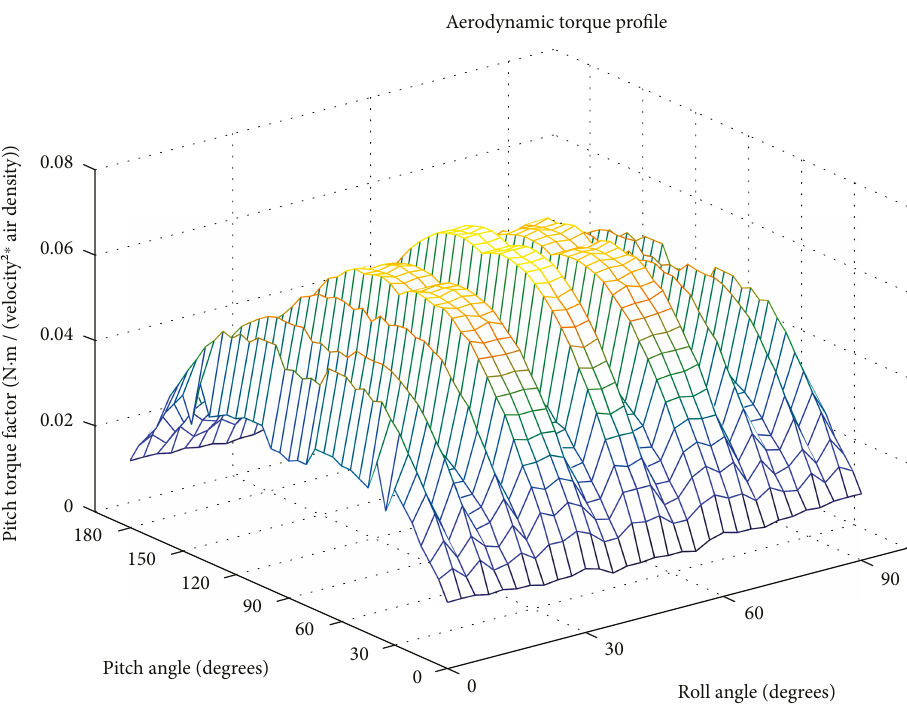
Figure 8: Aerodynamic torque pro fi le generated by rotating the satellite, which is modelled as a point cloud at various roll and pitch angles relative to the velocity vector, to compute the collective torque by each point facing the wind. SNAP uses the torque provided as a lookup table at